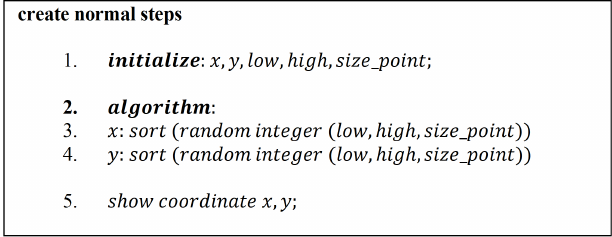
Figure 2. Algorithm for generating normal movements.